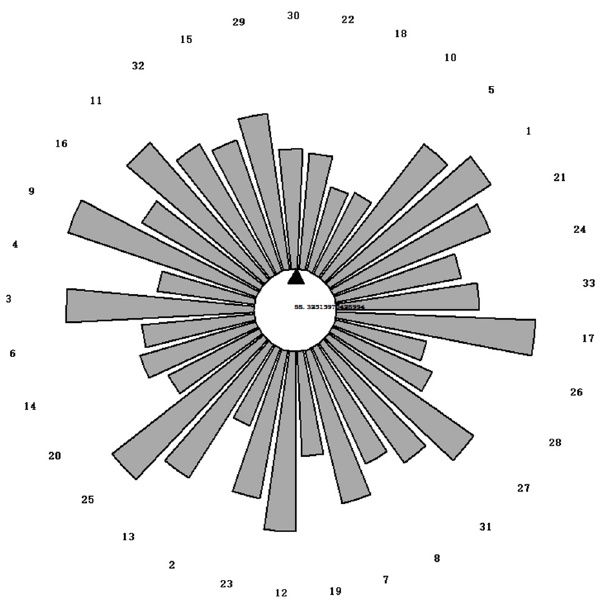
Figure 8. Blade layout diagram.